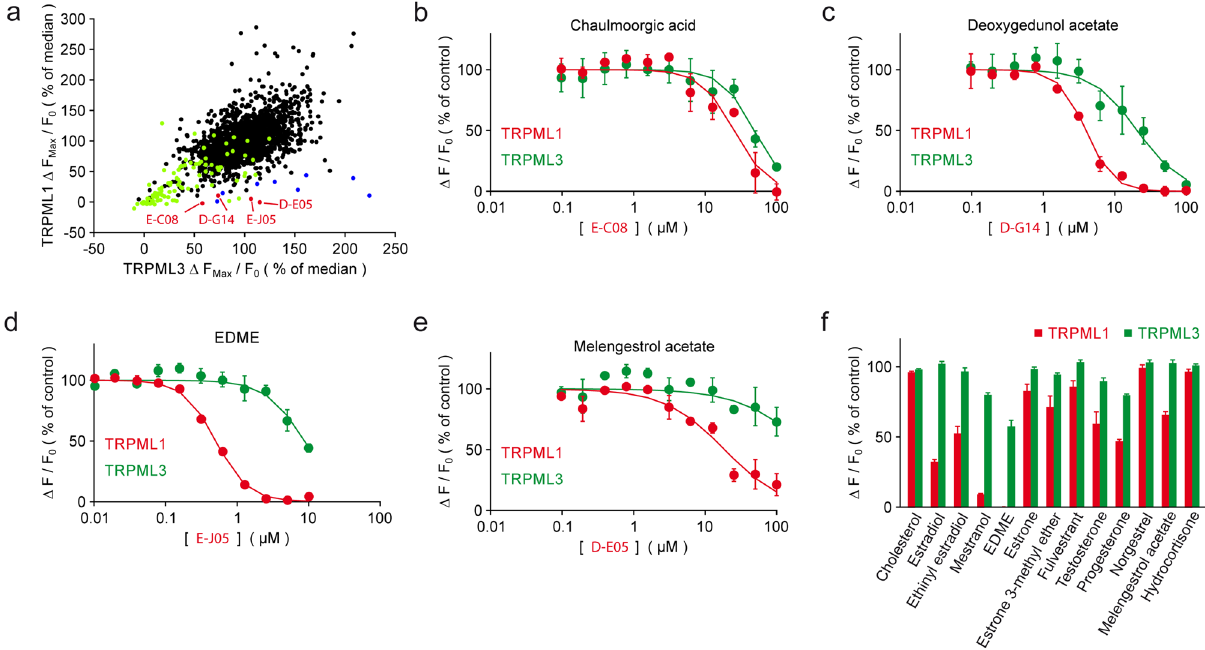
Figure 1. Compound screening and hit validation. ( a ) Dot plot showing the inhibitory effects of 2430 bioactive compounds (20 µM) on fluo4-loaded HEK293 cell lines stably expressing hTRPML1∆NC-YFP and hTRPML3- YFP after activation of the cells with 5 µM ML-SA1. Peak fluorescence intensities after stimulation were normalized to the median response in the respective screening plate. Black dots indicate compounds with no discernible effect on either TRPML1 or TRPML3. Green dots represent fluorescent compounds that were not further considered. Blue dots are notoriously positive hits previously identified in several other screened targets. Red dots indicate TRPML1-selective hits. ( b – e ) Representative concentration–response curves of the 4 specific hits in (A) for TRPML1 (red dots and lines) and TRPML3 (green dots and lines). ( f ) Effect of retested and pharmacologically relevant steroids on TRPML1 and TRPML3 at a concentration of 12.5 µM, which in the case of EDME completely blocks TRPML1. Shown is the inhibition of Fluo-4 fluorescence responses to stimulation with 5 µM ML-SA1 and normalization to an untreated control. Aggregated data sets from 3 to 5 independent experiments, each performed in duplicates, are displayed (means ±